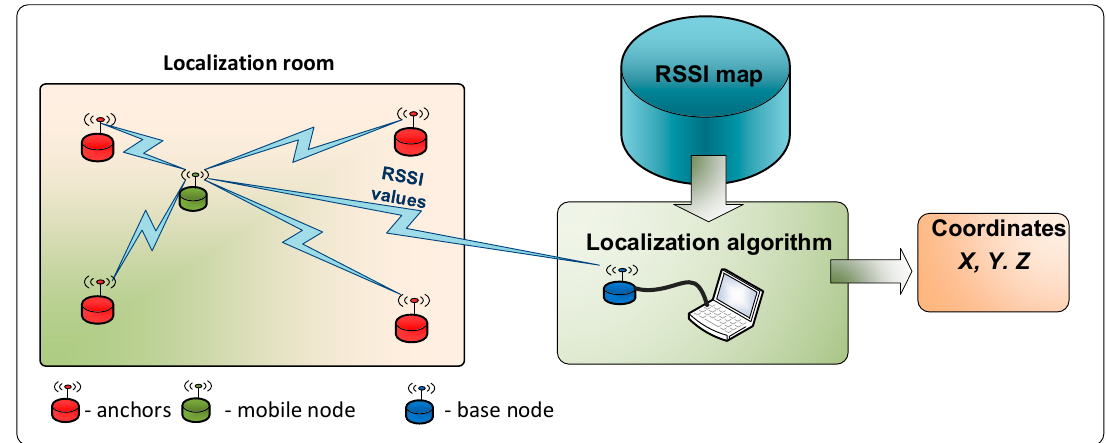
Figure 5. Online phase of the fingerprint localization.